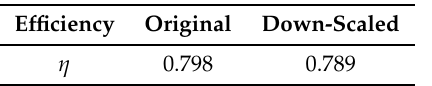
Table 6. Measured efficiency of starting and down-scaled systems.